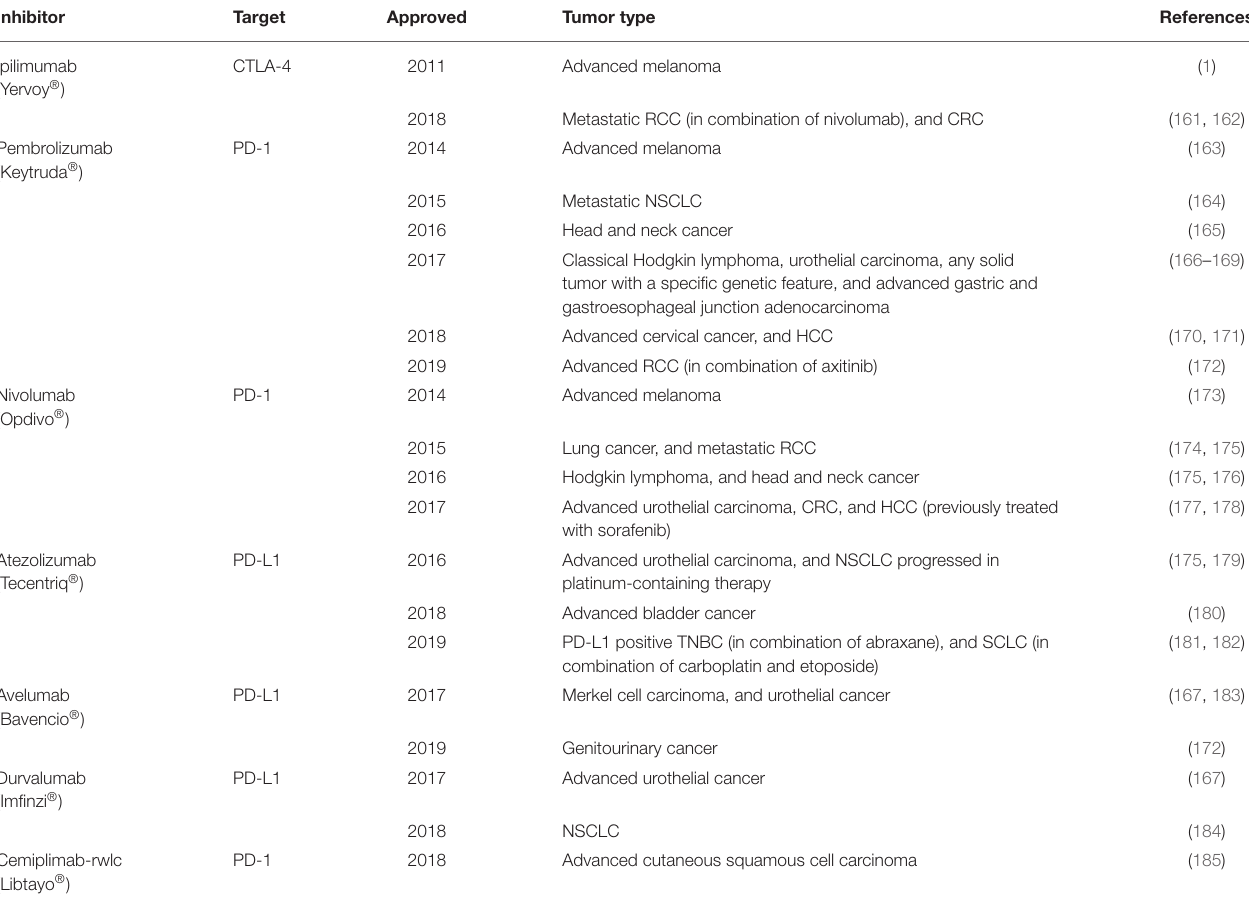
TABLE 1 | FDA-approved antibodies targeting immune checkpoints for treating different type of